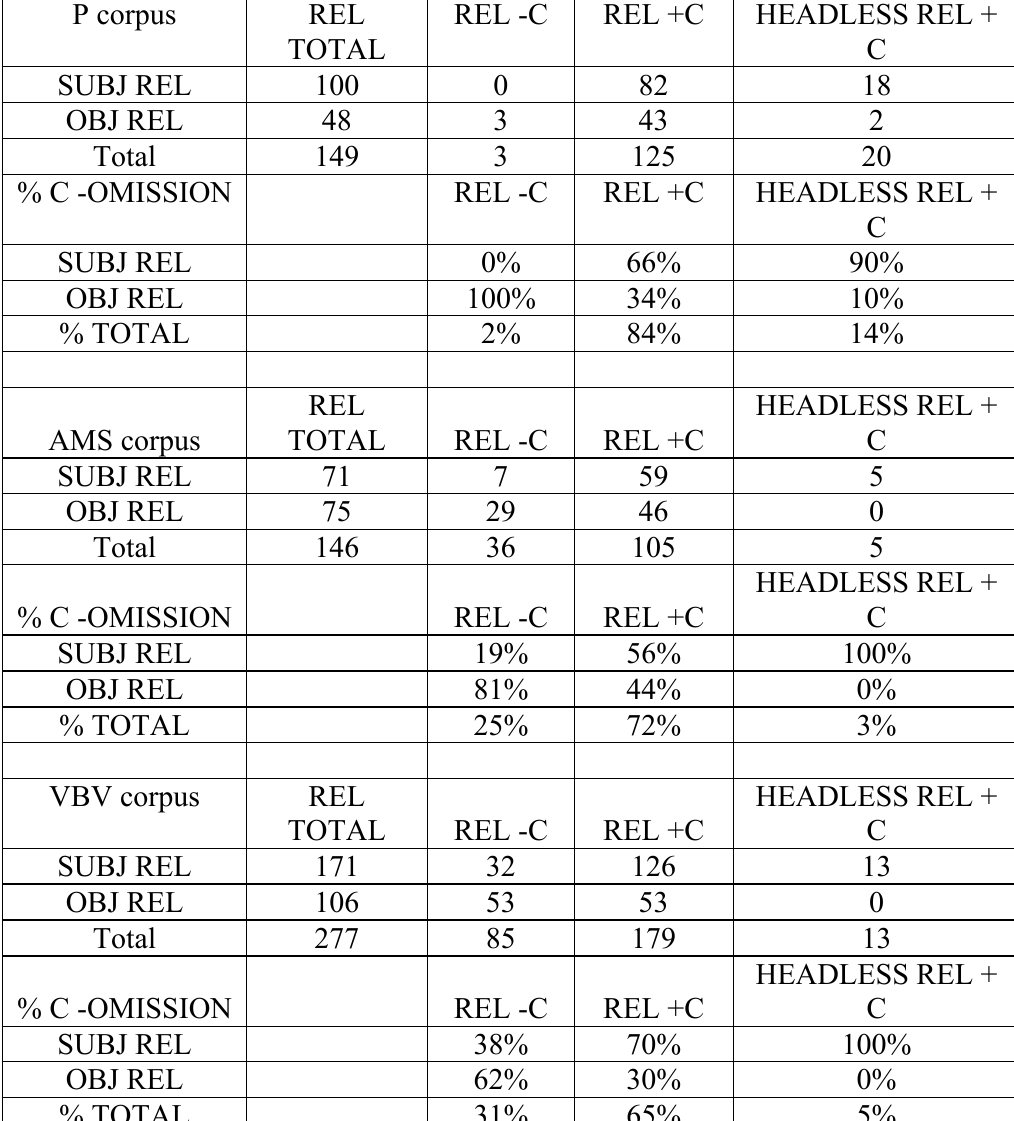
Table 1 . C-omission in relative clauses in Renaissance